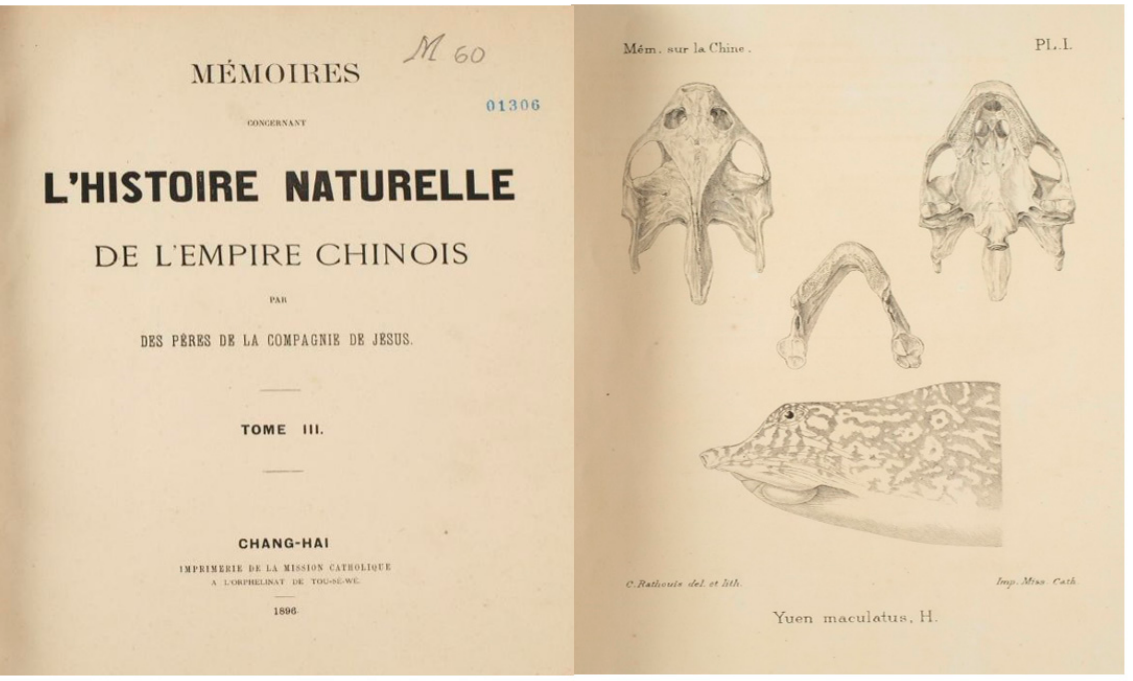
Figure 2. Mémoires Concernant l’Histoire Naturelle de l’Empire Chinois, Vol. III. Printed by Imprimerie de la Mission Catholique, a l’Orphelinat de T’ou-sè-wè, 1896.